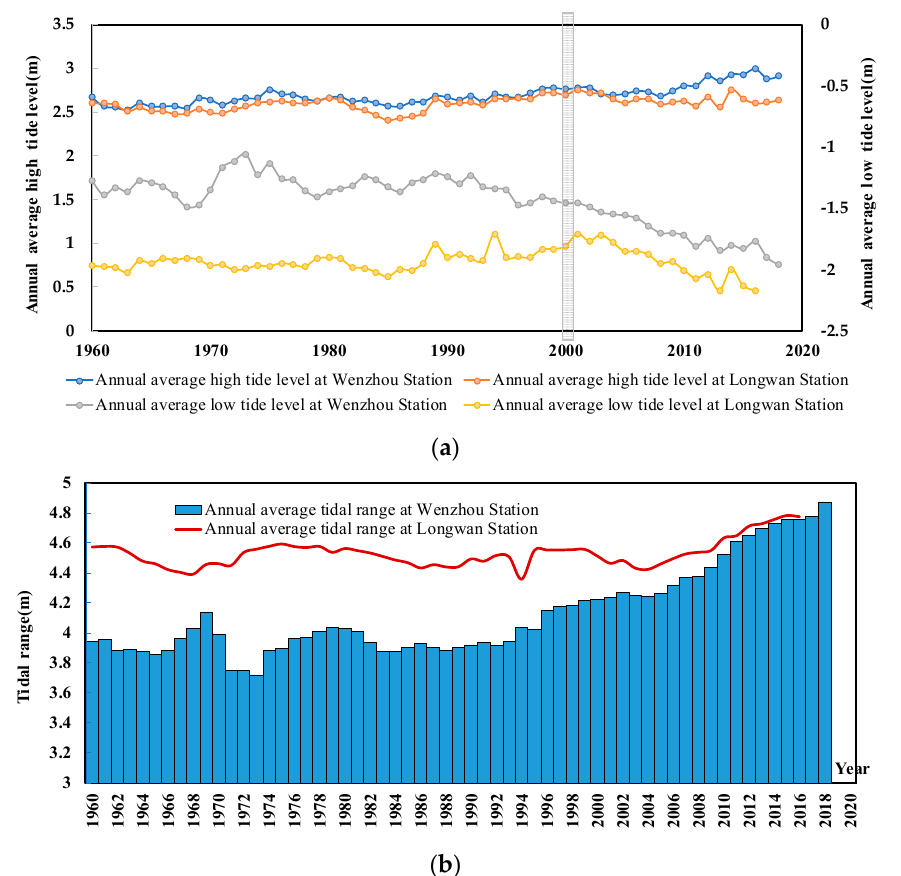
Figure 14. Change process of the tidal characteristic at Wenzhou and Longwan Stations: ( a ) Change process of annual average high and low tide levels; ( b ) Change process of annual average tidal range.